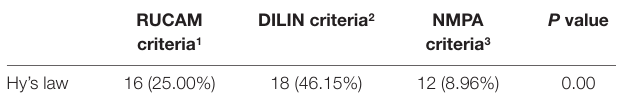
TABLE 3 | The number of cases fulfilling Hy’s law in three groups of positive cases.